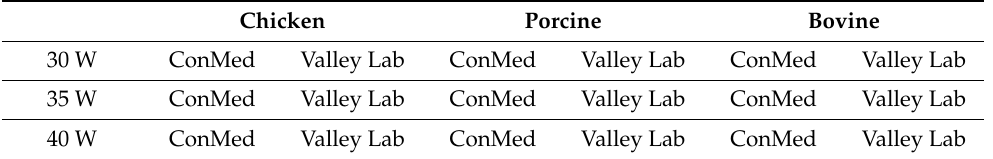
Table 1. Testing protocol for the cautery states for each of the 18 tests set-ups.